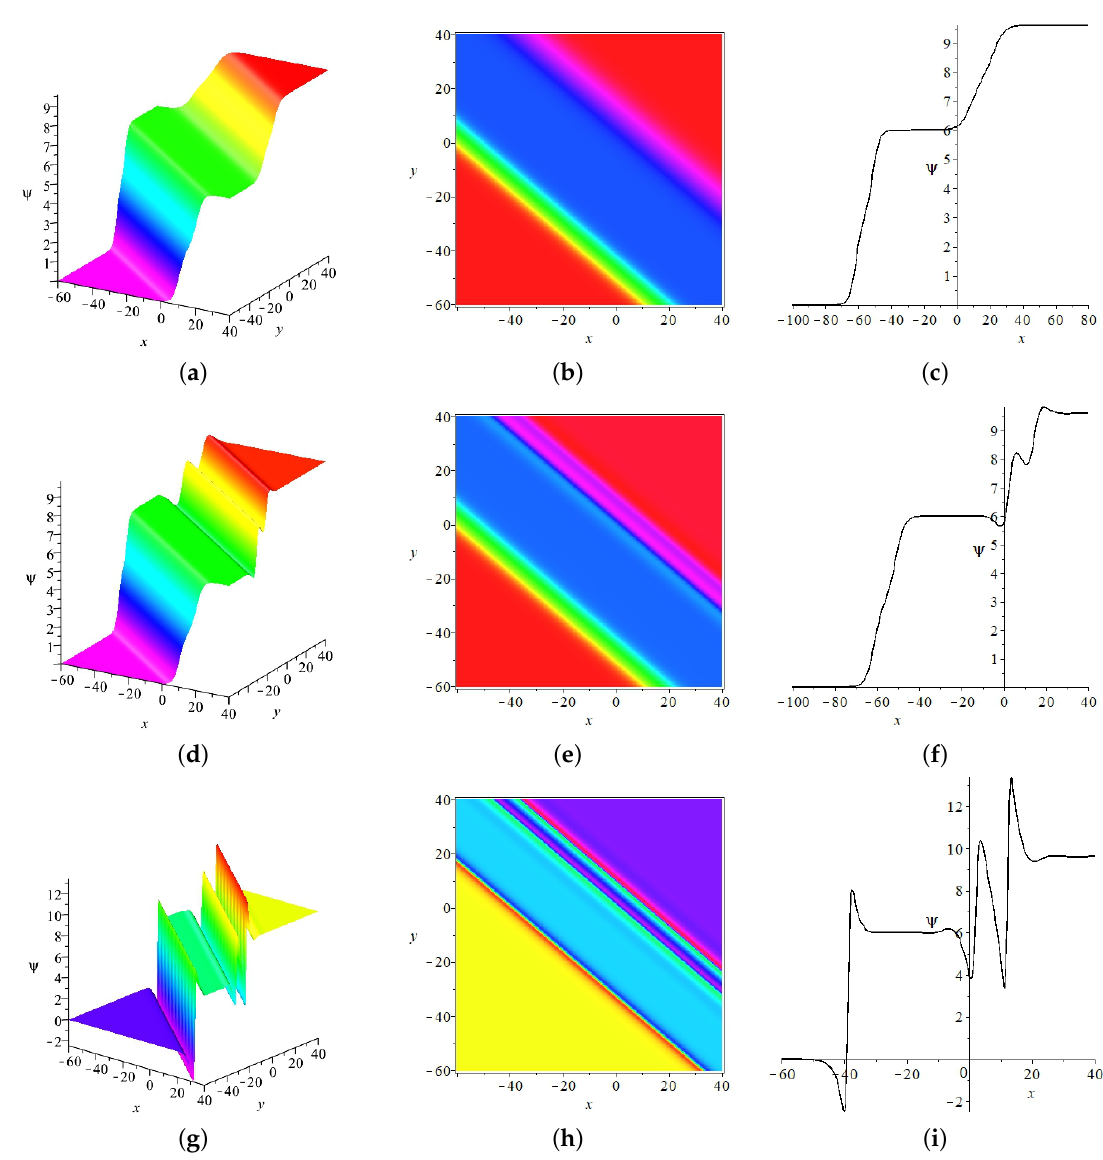
Figure 10. (Color online) The transformation of two-breather with r 2 = r 3 = r 4 = r 6 = r 7 = r 8 = 1, β 1 = β 3 = 2, κ 1 = κ 2 = 0. In ( a ), a 1 = 0.5, b 1 = 0.005, c 1 = 1.2, d 1 = 0, e 1 = 0.5, f 1 = − 3.5, γ 1 = 30, a 2 = 0.3, b 2 = 0.003, c 2 = 1.2, d 2 = 0, e 2 = 0.5, f 2 = − 3.5, γ 2 = 0. In ( d ), a 1 = 0.5, b 1 = 0.005, c 1 = 1.2, d 1 = 0, e 1 = 0.5, f 1 = − 3.5, γ 1 = 30, a 2 = 0.3, b 2 = 0.3, c 2 = 1.2, d 2 = 0, e 2 = 0.5, f 2 = − 3.5, γ 2 = 0. In ( g ), a 1 = 0.5, b 1 = 0.05, c 1 = 1.2, d 1 = 0, e 1 = 0.5, f 1 = − 3.5, γ 1 = 20, a 2 = 0.3, b 2 = 0.5, c 2 = 1.2, d 2 = 0, e 2 = 0.5, f 2 = − 3.5, γ 2 = 0. These three figures are three-dimensional stereograms of the two- breather transformation when t = 0, z = 0. ( b , e , h ) are the corresponding contour figure. ( c , f , i ) show the wave moves along the x axis when y = 0, t = 0, z = 0. Then, we further consider the velocity resonance of the transformed two-breather. The equal,